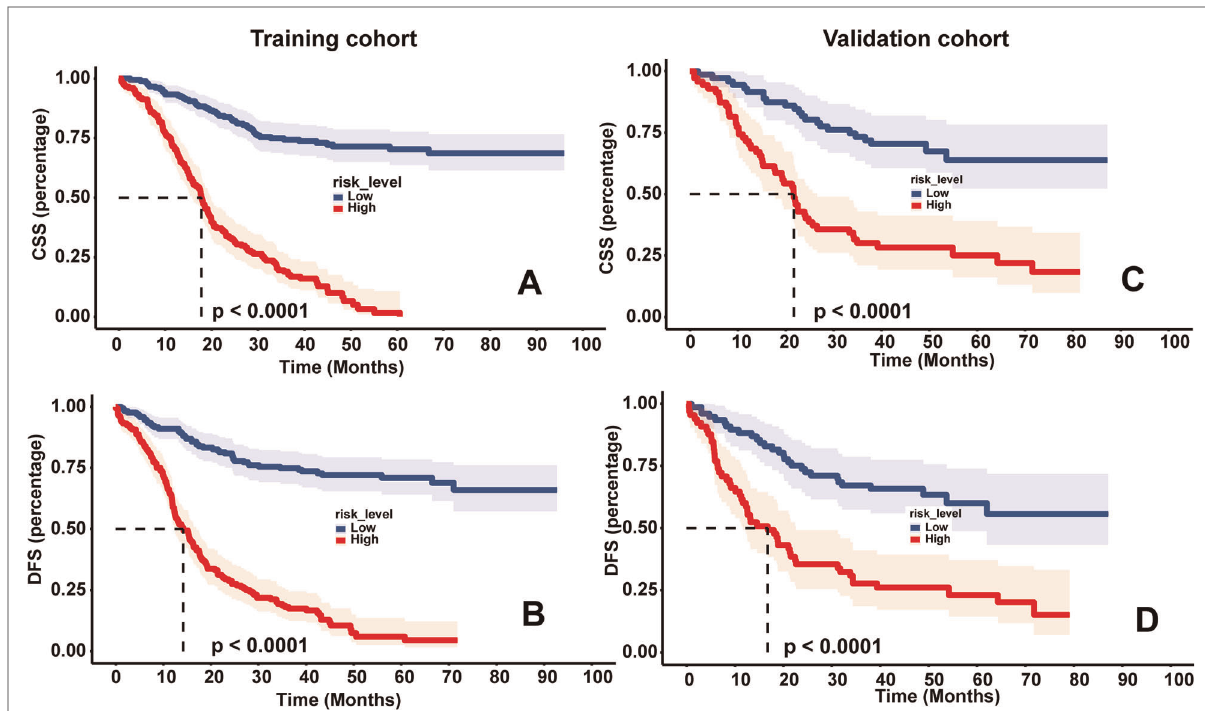
FIGURE 5 Kaplan – meier survival curves of cancer-speci fi c survival (CSS) ( A ) and disease-free survival (DFS) ( B ) in the training set based on risk scores; kaplan – meier survival curves of CSS ( C ) and DFS ( D ) in the validation set based on risk